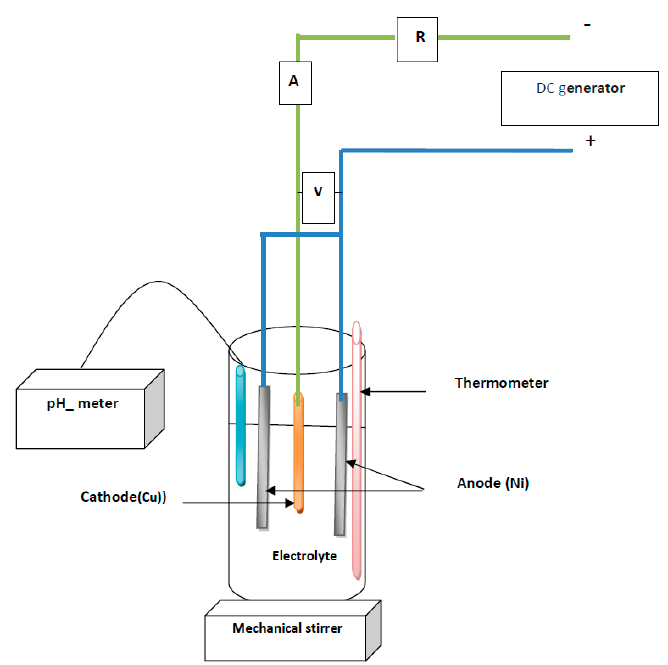
Figure 1. Schematic representation of the electroplating cell (R: Resistance; A: Ampermeter; V: Voltmeter).